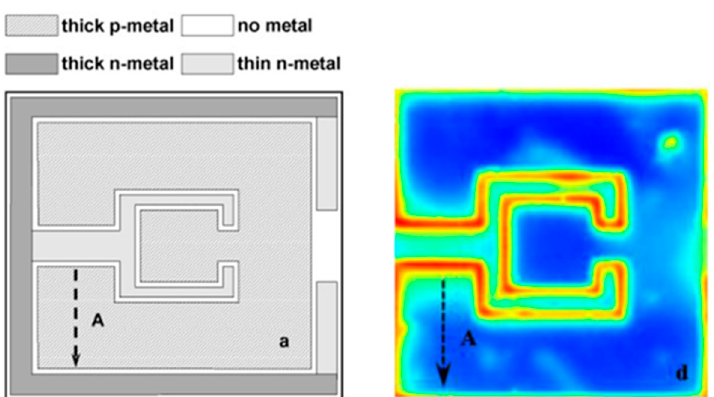
Figure 5. Image of lateral infrared (IR) distribution of a flip-chip LED fabricated with photolithog- raphy and dry reactive-ion etching. A schematic of the chip is shown on the left-hand side, while captured IR emissions are shown on the right-hand side. Reprinted with permission from Ref. [116]. Copyright 2013, John Wiley and Sons.